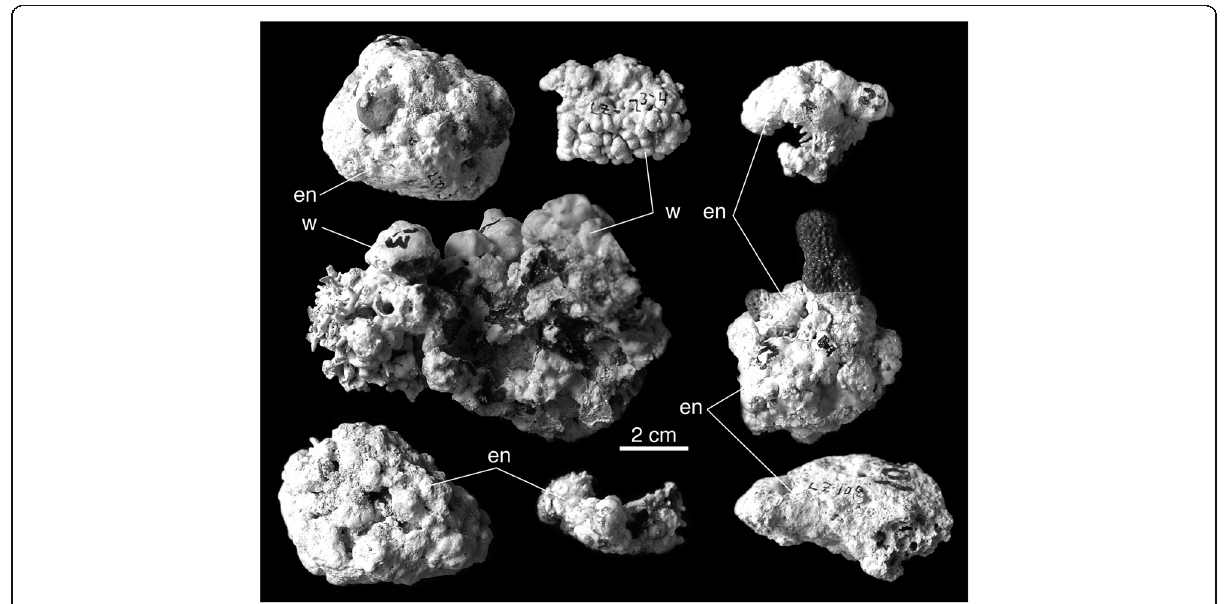
Fig. 2 Outer rhodolith surfaces from intertidal and shallow subtidal settings in One Tree Reef and Lizard Island showing the range in size and growth forms (en, encrusting; w,